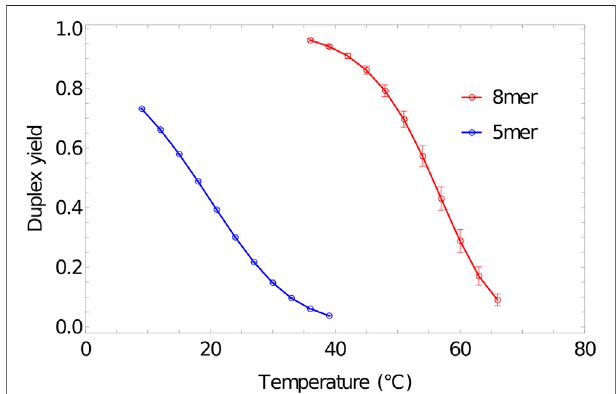
FIGURE 8 | Melting transition of oligonucleotides. Fractional yield of 5mer (3 ′ -AGTCT-5 ’ /3 ′ -AGACT-5 ′ ) and 8mer (3 ′ -ACTGACGT-5 ’ /3 ′ -ACGTCA GT-5 ′ ) duplexes in bulk ( f ∞ ( T ) )) as predicted by oxDNA1.5 at a total concentration of 7 . 96 × 10 − 4 M for each